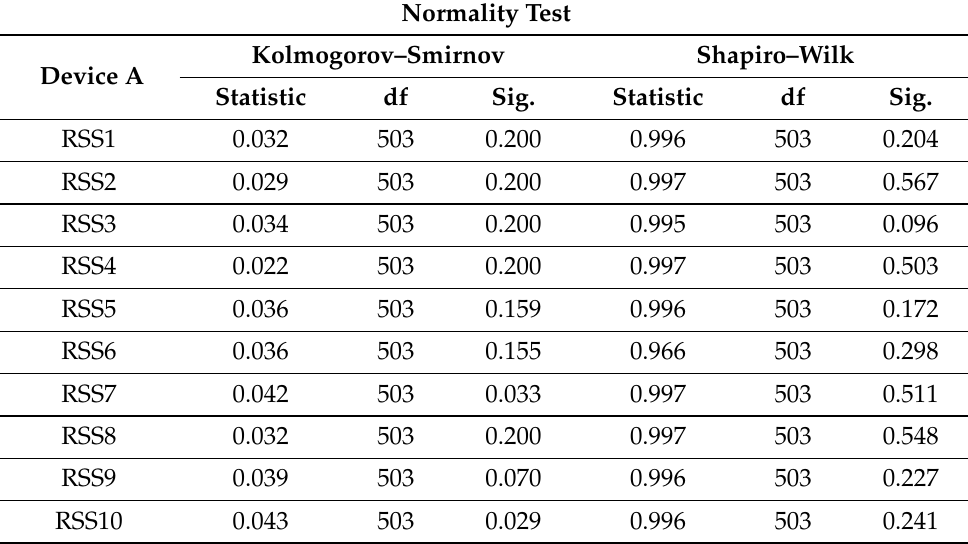
Table 1. Normality test